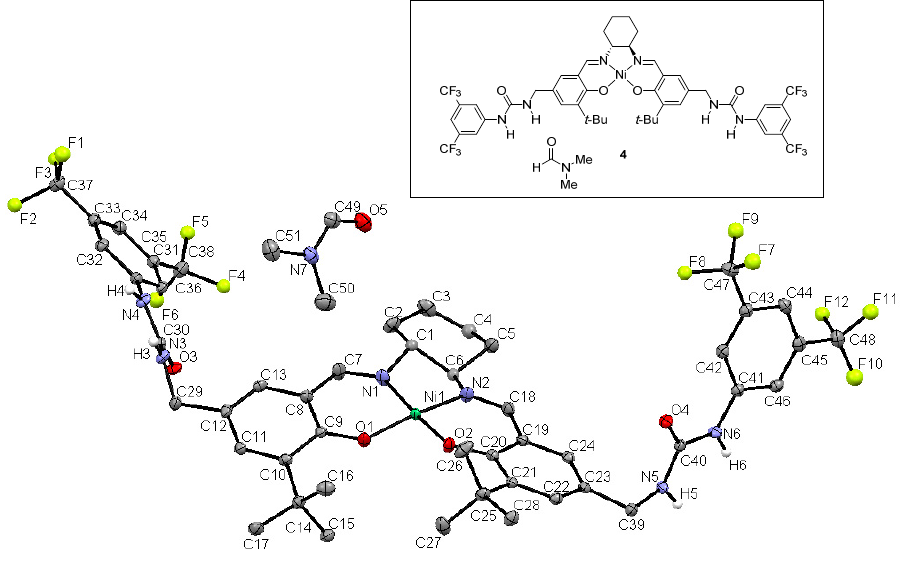
Figure 3. X-ray crystal structure of bis-urea salen nickel complex 4.